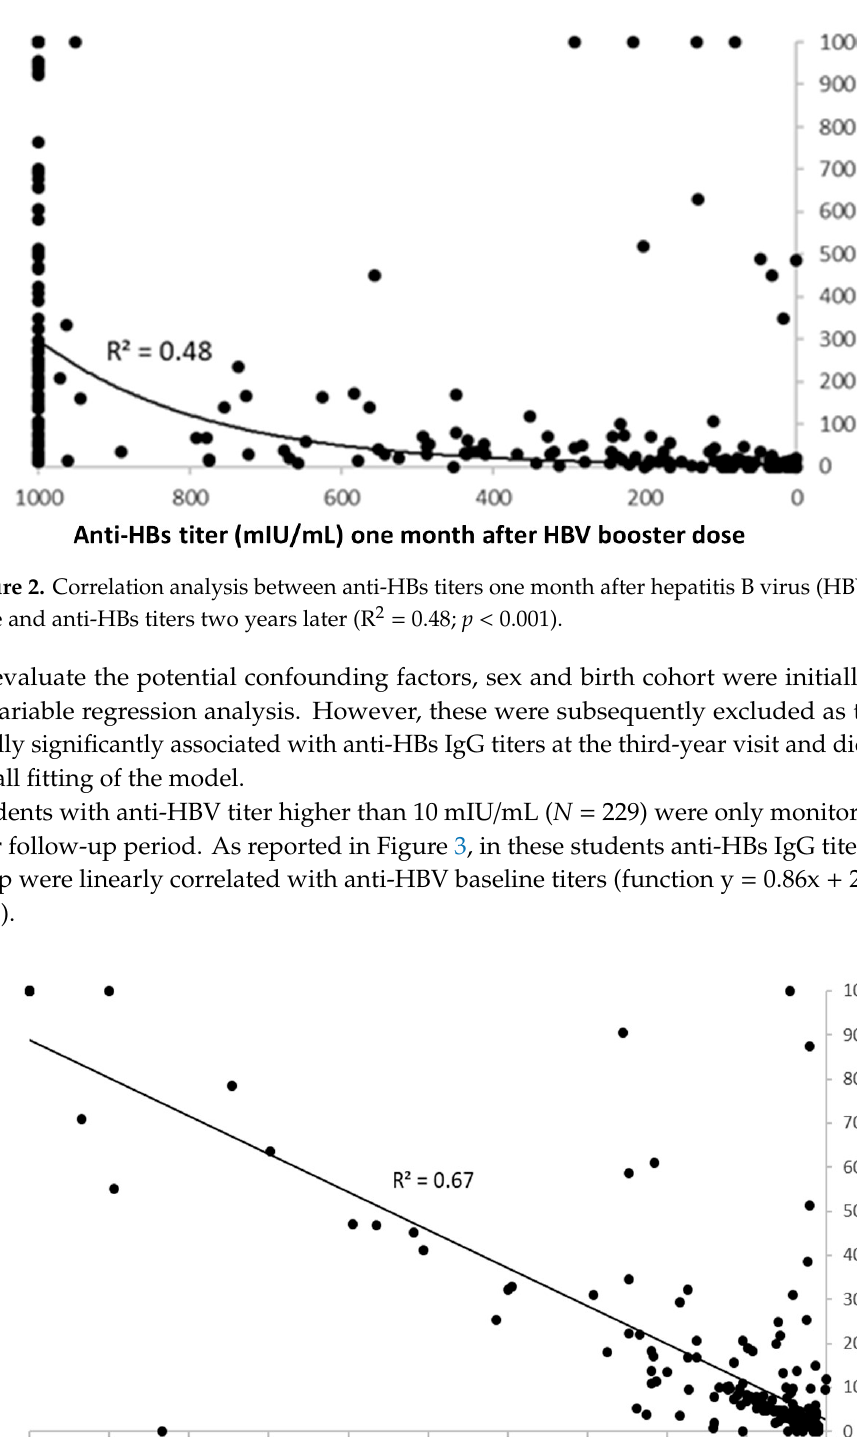
Table 2. Relative frequencies of students with hepatitis B surface antibody (anti-HBs) titers <10 mIU/mL at 2-year follow-up visit, stratified according to their basal value and anti-hepatitis B virus (HBV) boostering.